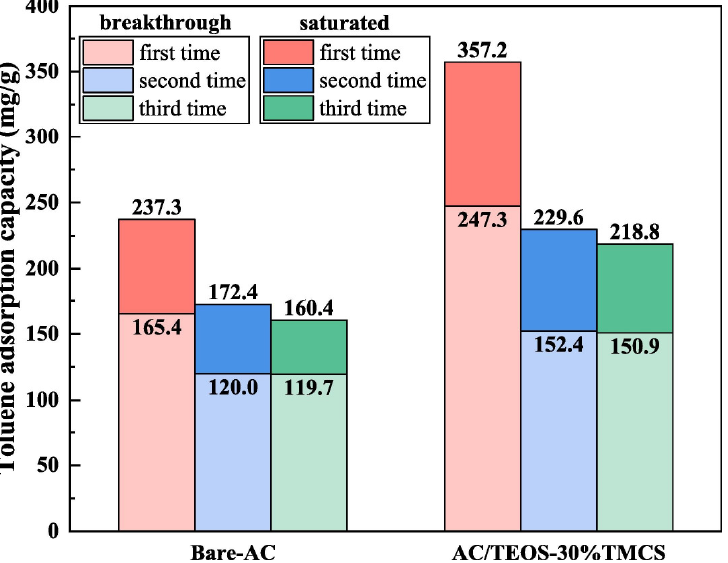
Figure 3. Breakthrough adsorption capacity and saturated adsorption capacity of toluene for regenerated ACs [21].